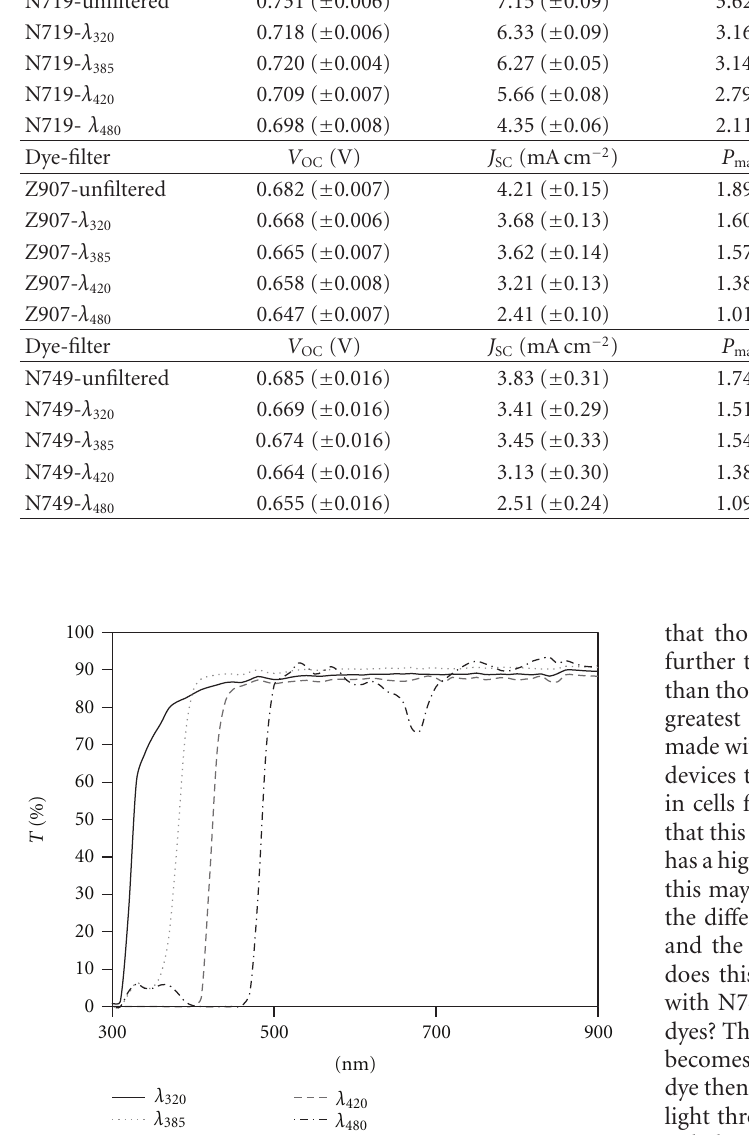
Figure 3: UV-Vis % T curves of PET-based UV cut-o ff